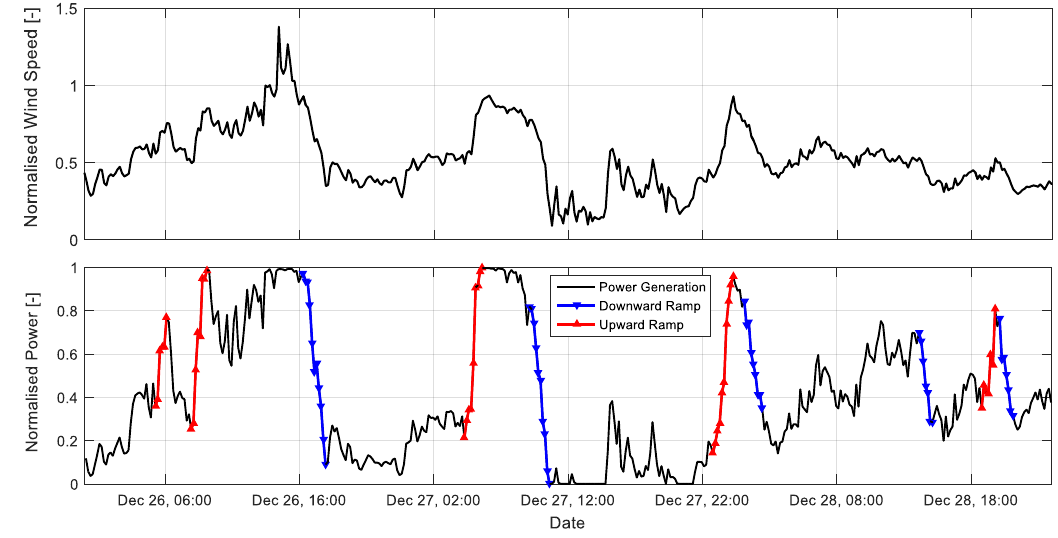
Figure 2. Example time series of wind speed and generated power of a single wind turbine with wind ramps marked for a time window of 60min and a change of power of 40%. Each data point in the time series corresponds to a 10-minute average. Reproduced without modifications from Würth et al.